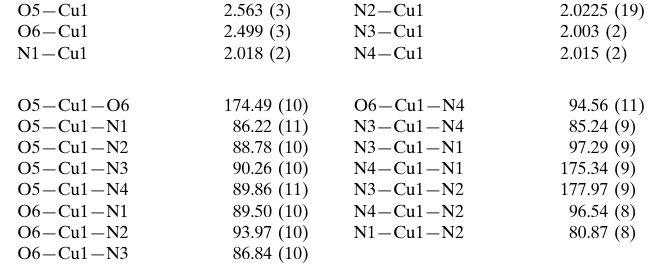
Selected geometric parameters (A˚ , (cid:2) ).